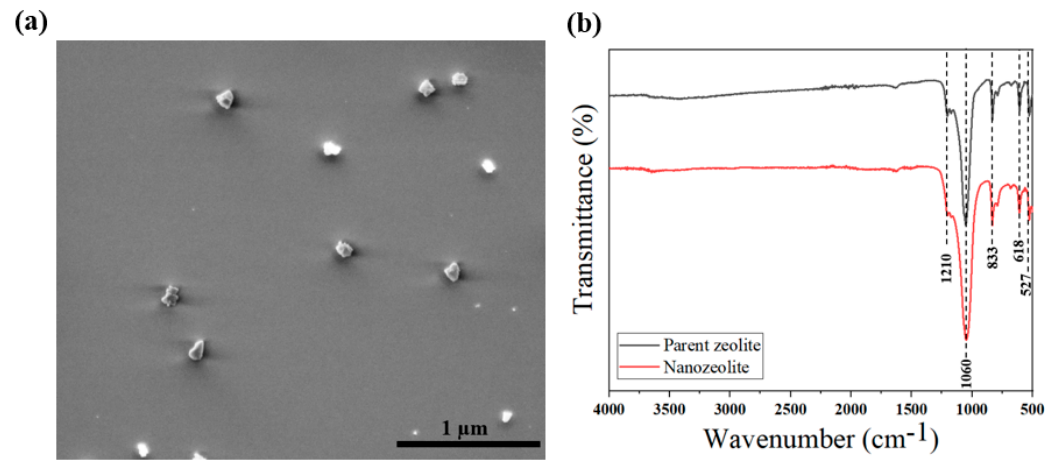
Figure 2. ( a ) SEM image of nanozeolites ( b ) comparison of FTIR spectrum of nanozeolite with parent zeolite.